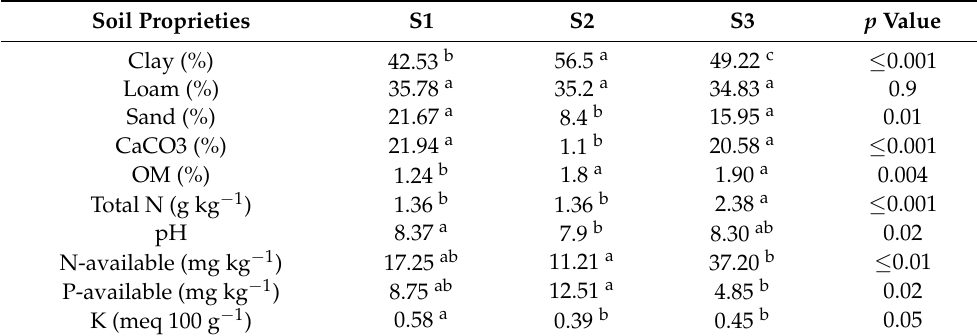
Table 1. Soil physico-chemical proprieties of the three studied sites. Soil Proprieties